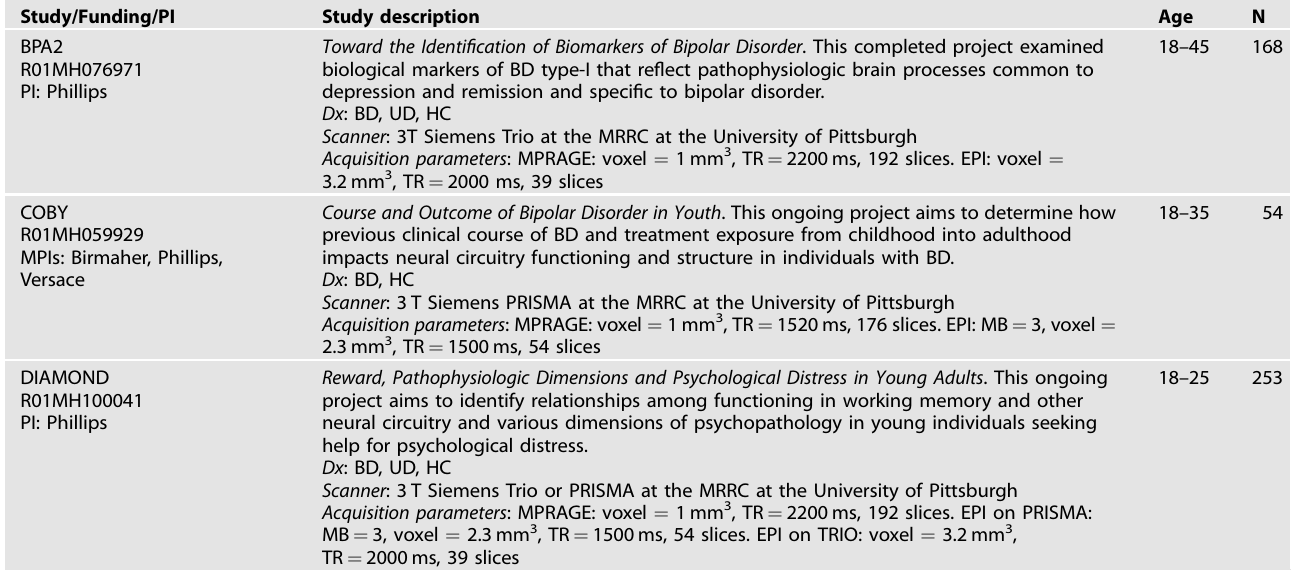
Table 1. Description of the studies included to the